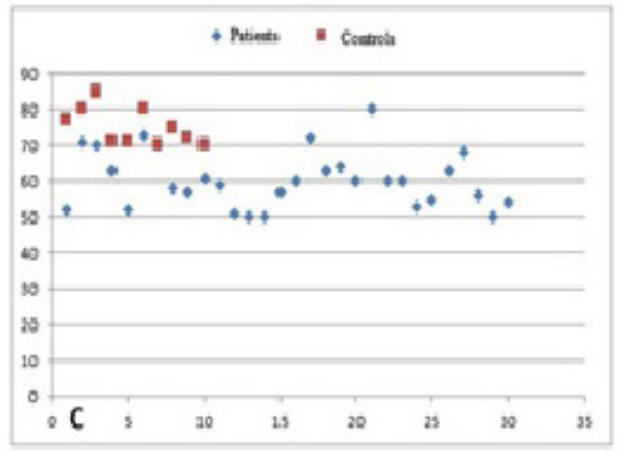
Fig. 3 - Comparison of the dihydrorhodamine 123 test stimulation index values between the control and patient